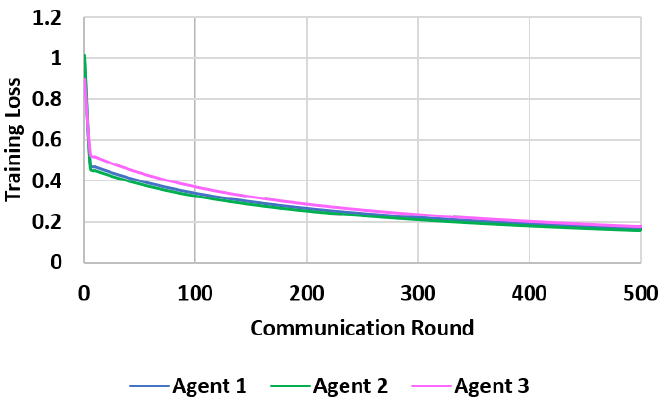
Figure 17. FedResilience’s impact on participating FL agents’ (three agents and two stragglers) model loss for the prediction of CIAs’ resource-sharing capability.